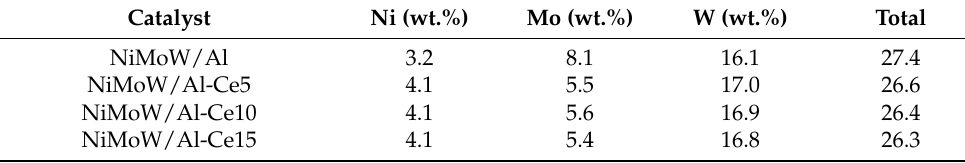
Table 2. Metal content of calcined NiMoW/Al-Ce( x ) catalysts (from